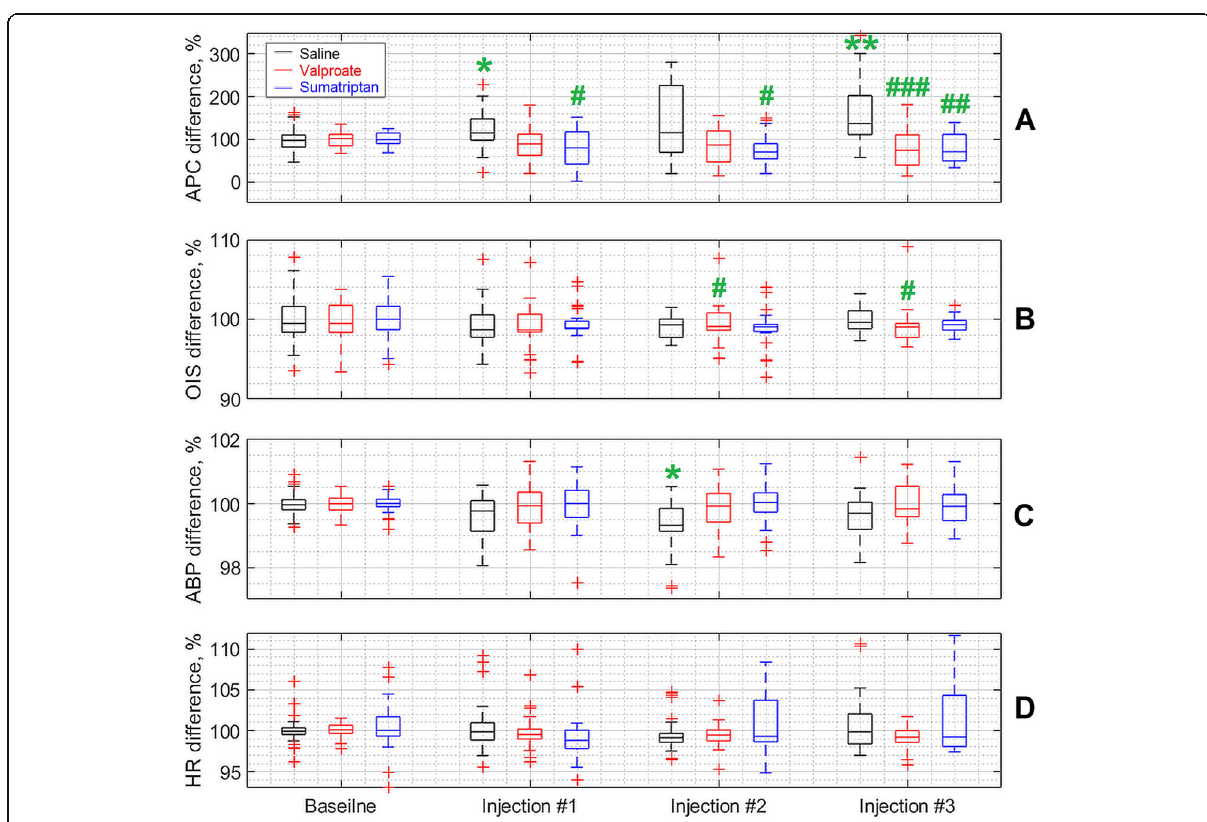
Fig. 6 Dynamics of changes in parameters of systemic hemodynamics and PPG due to CCW electrical stimulation. Each box plot is a composite of indicators of a specific parameter for a 30-minute interval before (baseline stage) and after each of three infusion steps of the testing substance. The black, red and blue boxes correspond to the saline, valproate and sumatriptan infusion group, respectively. Green stars indicate statistical differences in relation to the baseline stage, whereas green grids represent differences between testing substance and saline. One symbol corresponds to p < 0.05, two of them correspond to p < 0.01, and three of them correspond to p < 0.001. All statistical significance is indicated with Bonferroni corrections for